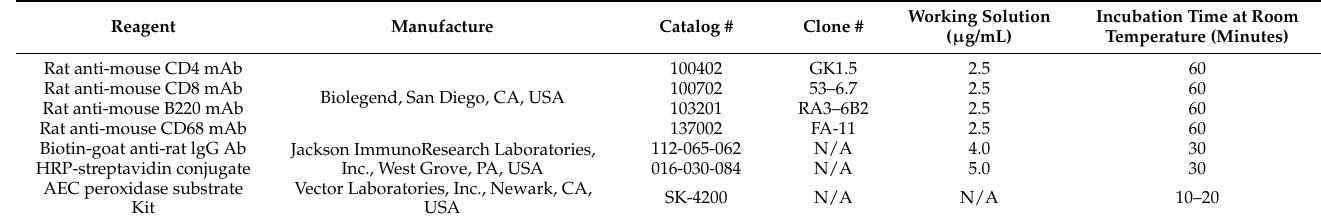
Table 1. Sources and working conditions for immunohistochemical reagents